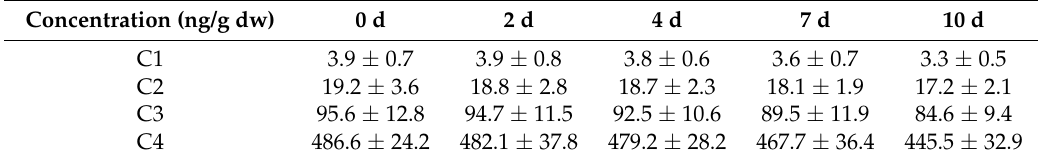
Table 1. The measured concentrations of EHDAB in sediments with different